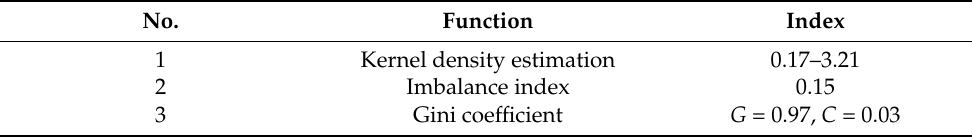
Table 3. Spatial indices of the NRTTC based on function